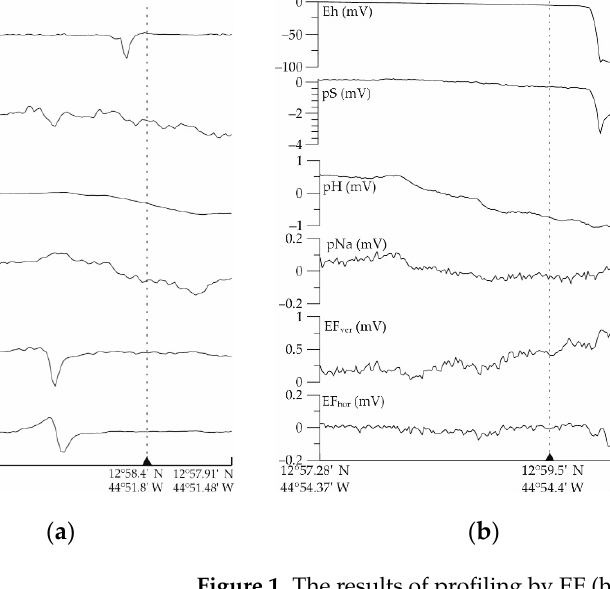
Figure 1. The results of profiling by EF (horizontal and vertical components), Eh, pH, pNa and pS sensors: ( a ) over the Ashadze-1 field at 30–40 m above the bottom; ( b , c ) over the Ashadze-2 field at 110–150 m above the bottom. The dotted line shows the position of the hydrothermal source.